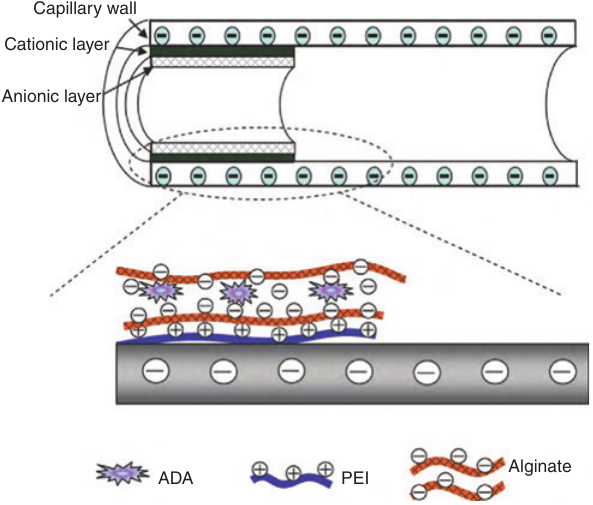
Figure 2: Schematic representation of the immobilized capillary enzyme microreactor. Enzyme was encapsulated in alginate and then immobilized on the surface of capillary inlet via the ionic binding. This image was reprinted from Ji et al. (2010) with permission from